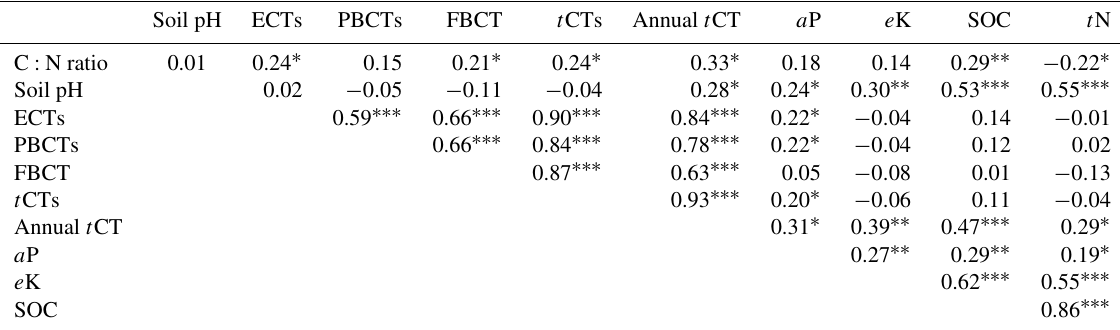
Table 4. Pearson correlation coefficients showing the relationships between soil and plant chemical parameters.